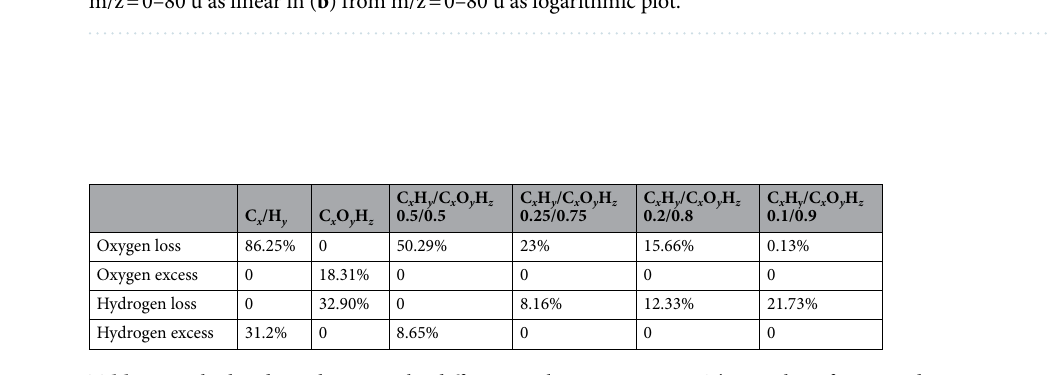
Table 3. Calculated stoichiometry by different peak interpretations. The overlap of C x H y and C x O y H z in certain areas were calculated (see supplementary part Table A 2 marked in